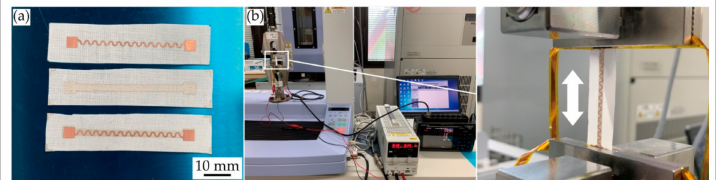
Figure 3. Optical images of ( a ) fabricated samples; and ( b ) measurement setup for single and cyclic tensile